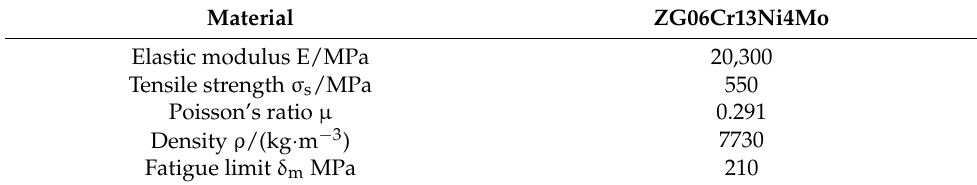
Table 3. Mechanical properties of ZG06Cr13Ni4Mo.